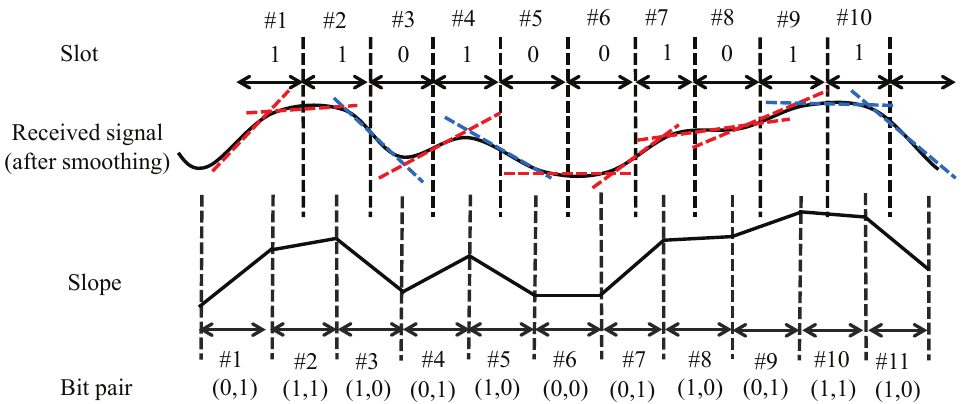
Figure 5. Illustration of the pattern-based decoding